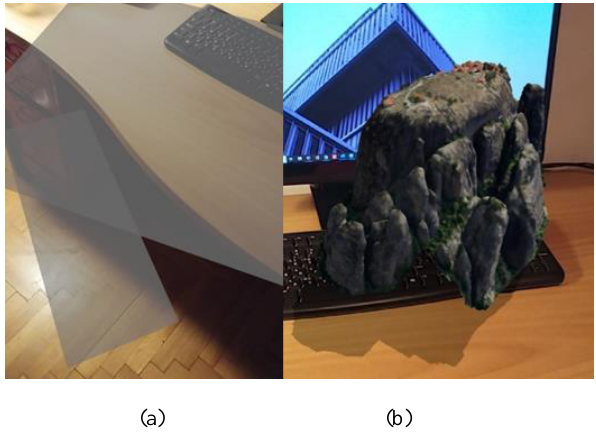
Figure 5. The plane selection scene: (a) semi-transparent surfaces are displayed to indicate the real ones (b) 3D model